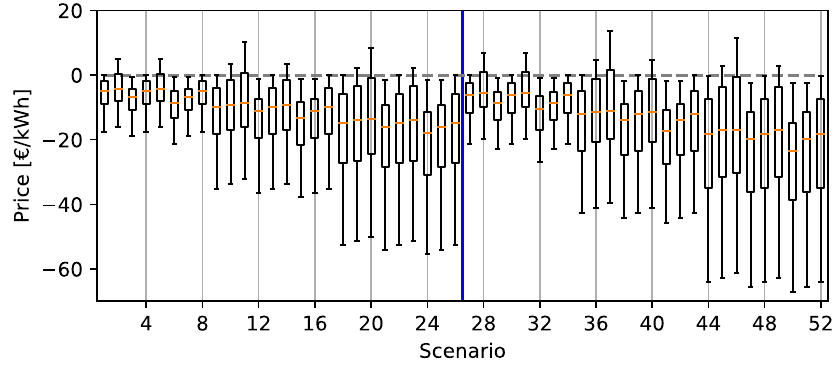
Figure 9. Aggregator profit by each scenario in Case